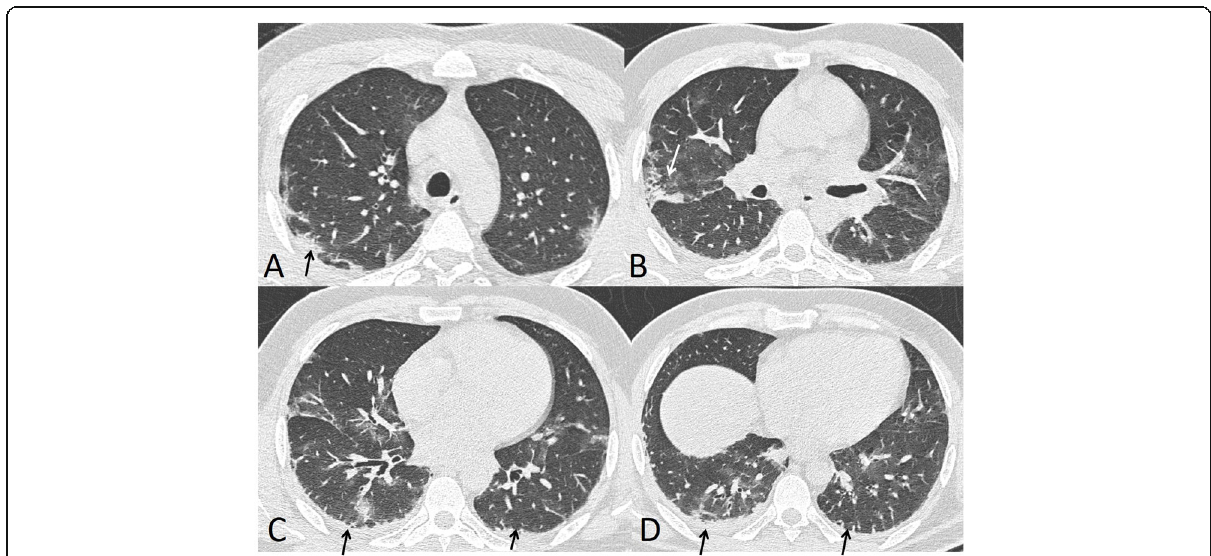
Fig. 3 A 48-year-old male with multiple subpleural lines (black arrow in a ), consolidation patch with air bronchogram (white arrow in b ), and bilateral minimal pleural effusion (black arrow in c and d ). Total severity score = 12